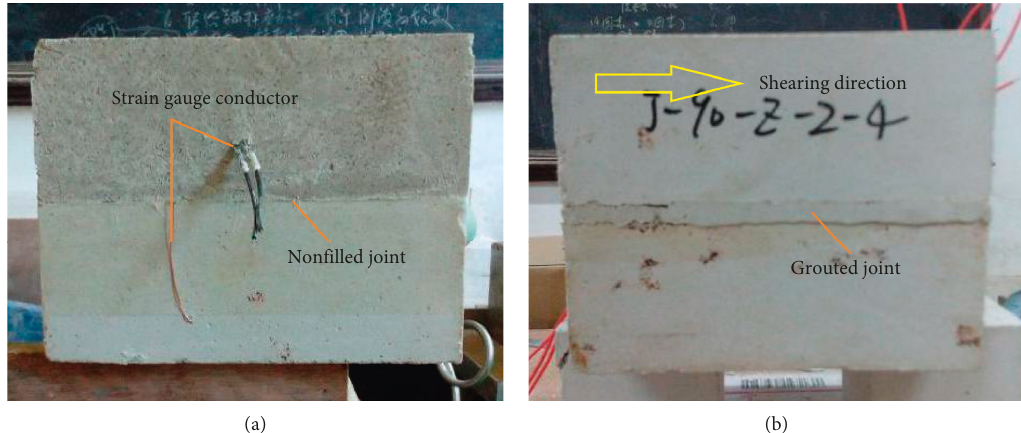
Figure 2: Joint sample. (a) Bolted nonfilled joint. (b) Bolted grouted